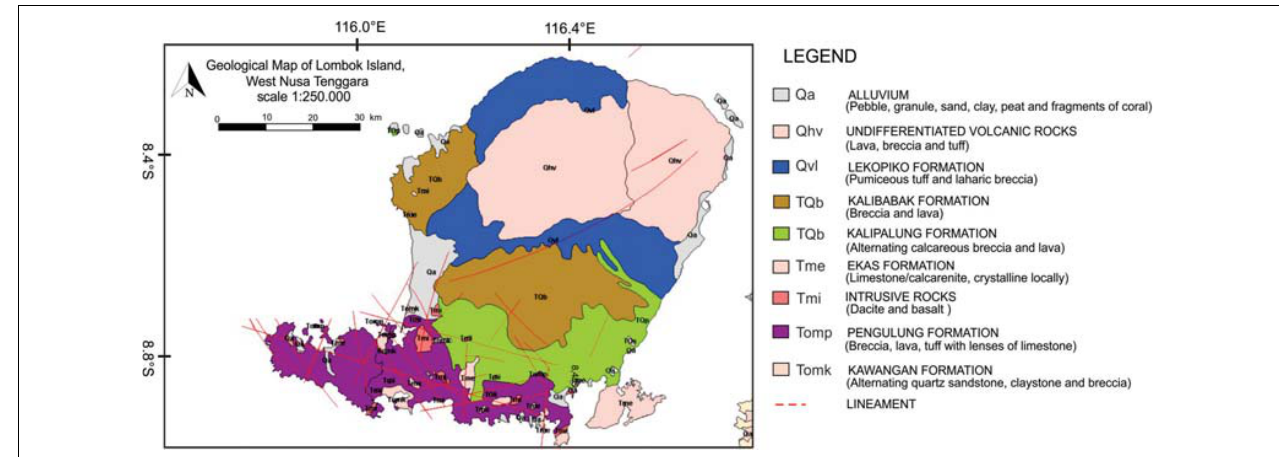
FIGURE 2 | Geological map of Lombok, West Nusa Tenggara modified from Mangga et al. (1994).